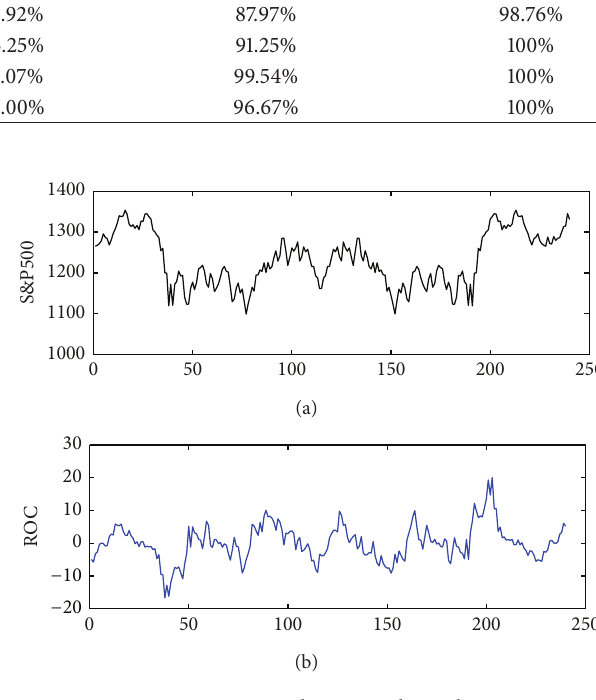
Figure 2: S&P500 annual RSI until March 27, 2012. Figure 3: S&P500 annual ROC until March 27,